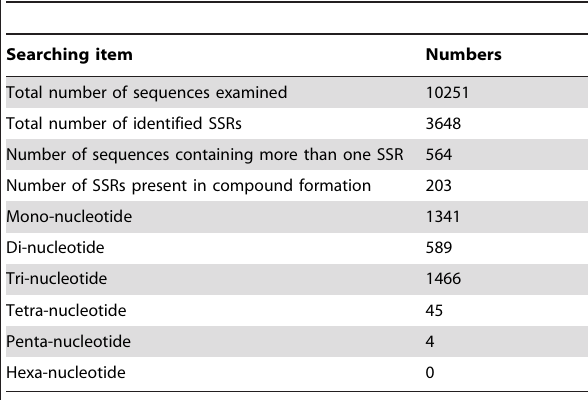
Table 3. Summary of simple sequence repeat (SSR) types in Youngiajaponica .